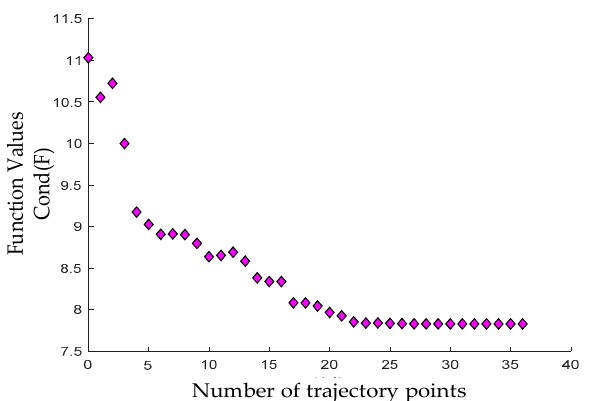
Figure 5. Condition number versus trajectory points for the actual 2-DOF manipulator. Sensors 2019 , 19 , x12